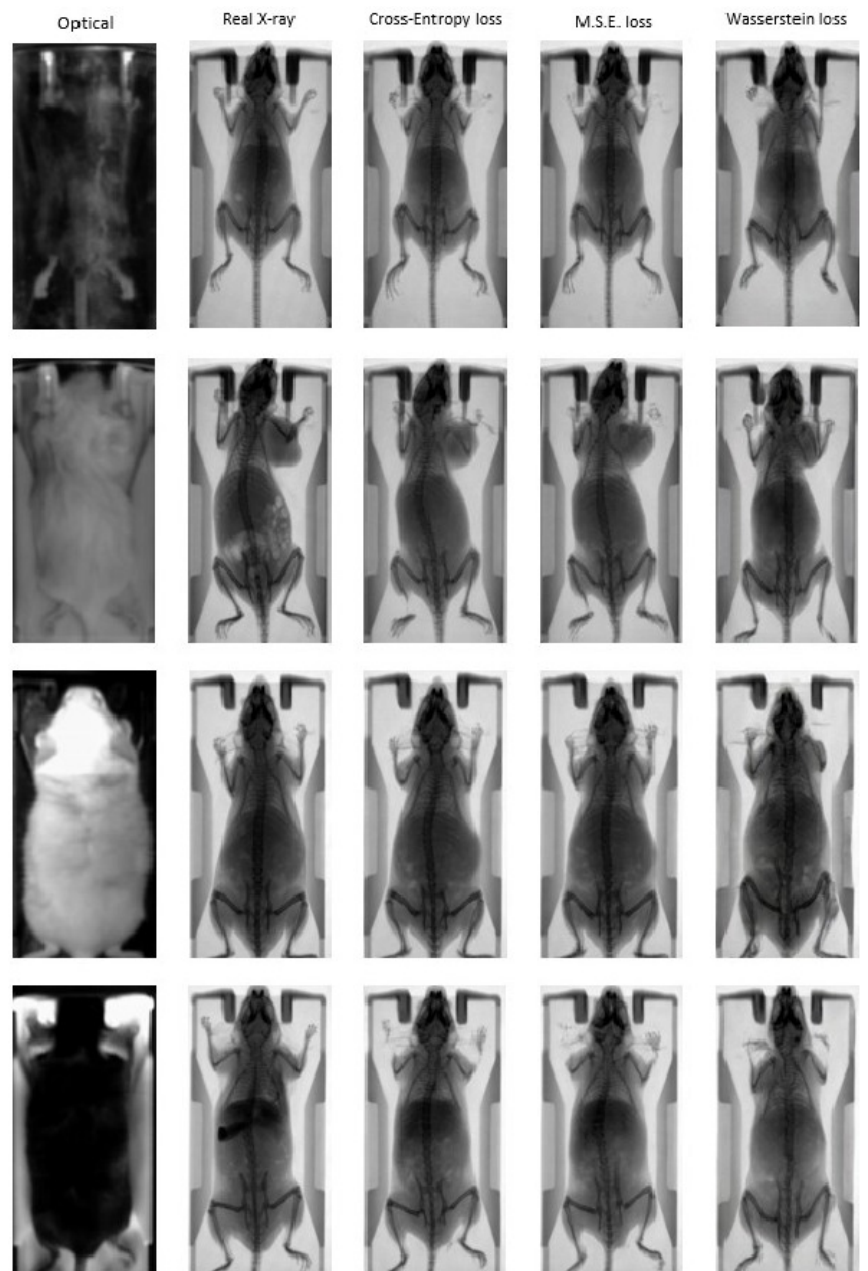
Figure 6. Indicative “fake” X-ray images from the pix2pix trained network using different loss functions: Cross Entropy (3rd column); MSE (4th column); Wasserstein distance (5th column). The input photographic images and the corresponding ground truth images are presented in the first two